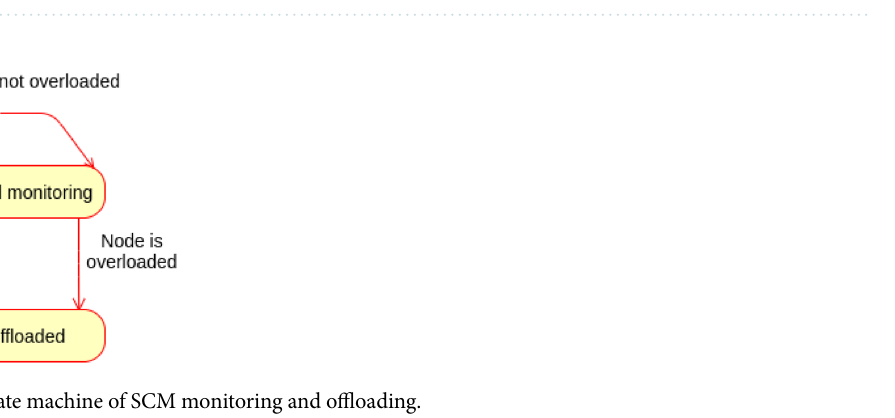
Figure 15. Behaviour of SCM monitoring and offloading.